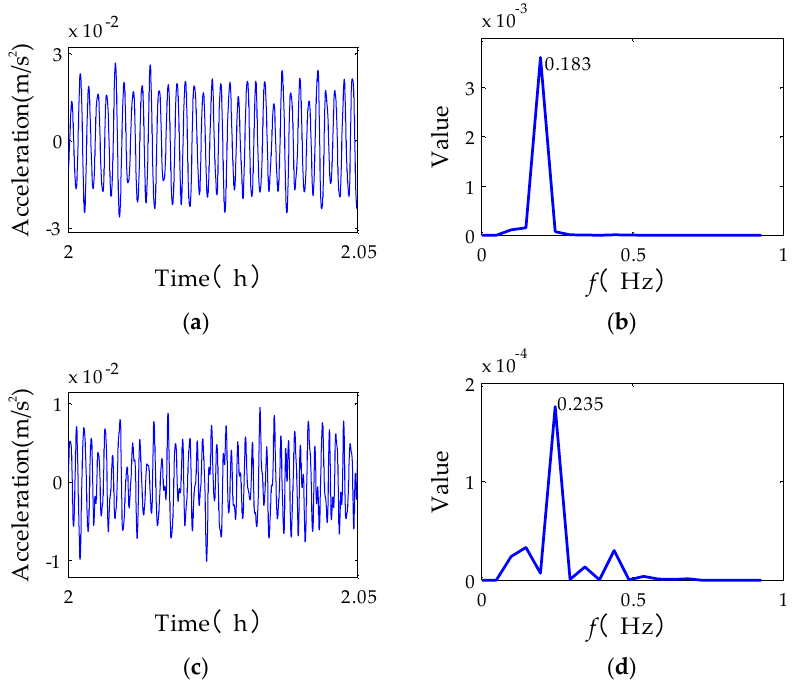
Figure 21. Selected acceleration response and its power spectral density (PSD) on 1 January: ( a ) Acceleration at quarter span; ( b ) PSD at quarter span; ( c ) acceleration at half span; ( d ) PSD at half span.